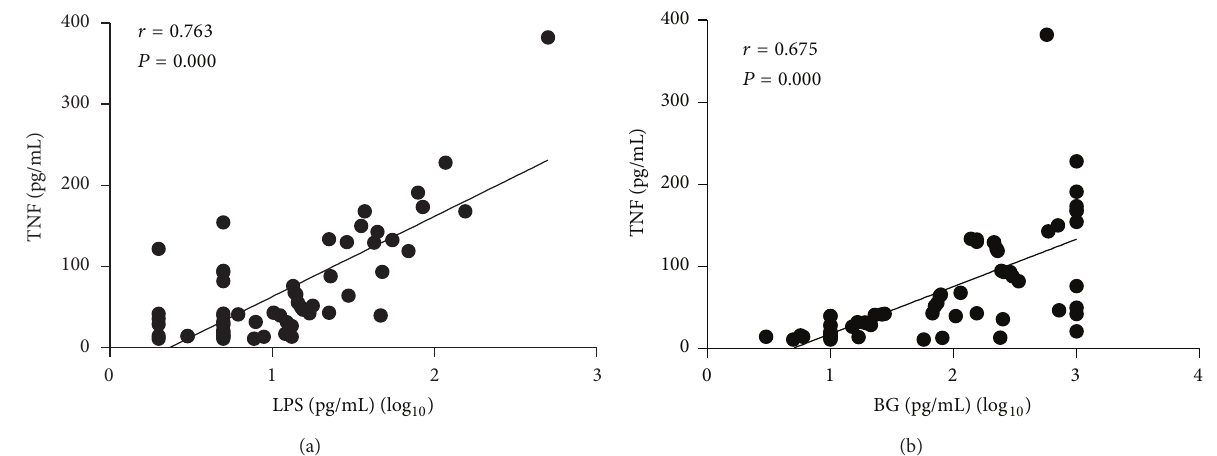
Figure 4: Correlation between TNF and LPS or BG in CD patients. The levels of TNF were analyzed in 46 A-CD and 22 R-CD patients by ELISA. The levels of TNF were significantly associated with the concentration of LPS ((a), 𝑟 = 0.763 , 𝑃 = 0.000 ) or BG ((b), 𝑟 = 0.675 , 𝑃 = 0.000 ), respectively.